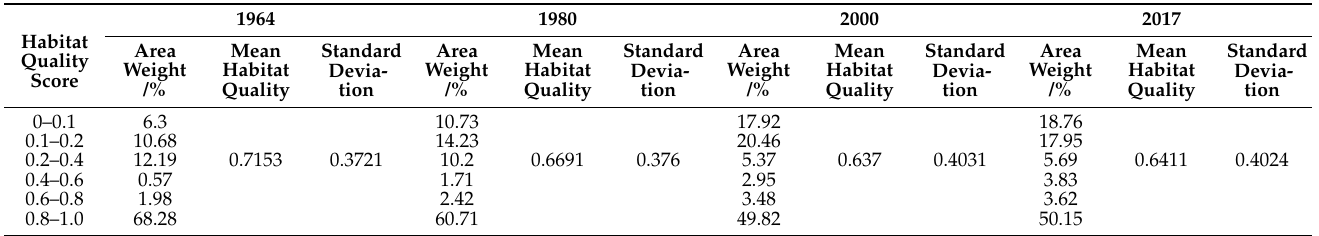
Table 10. Spatial statistics of habitat quality of wild apple forest in the Mohe Basin from 1964 to 2017.